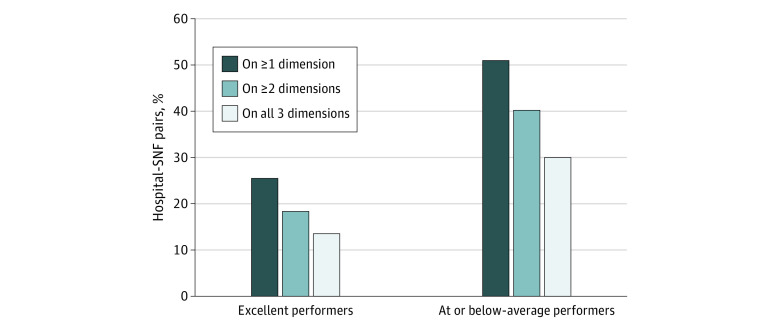
Skilled Nursing Facility (SNF) Ratings: Completeness, Timeliness, and Usability of Information to Support Care TransitionsData are for 471 hospital-SNF pairs. A rating of 5 on a Likert scale of 1 to 5 points indicated excellent performance, whereas a rating of 3 or lower indicated below-average performance.